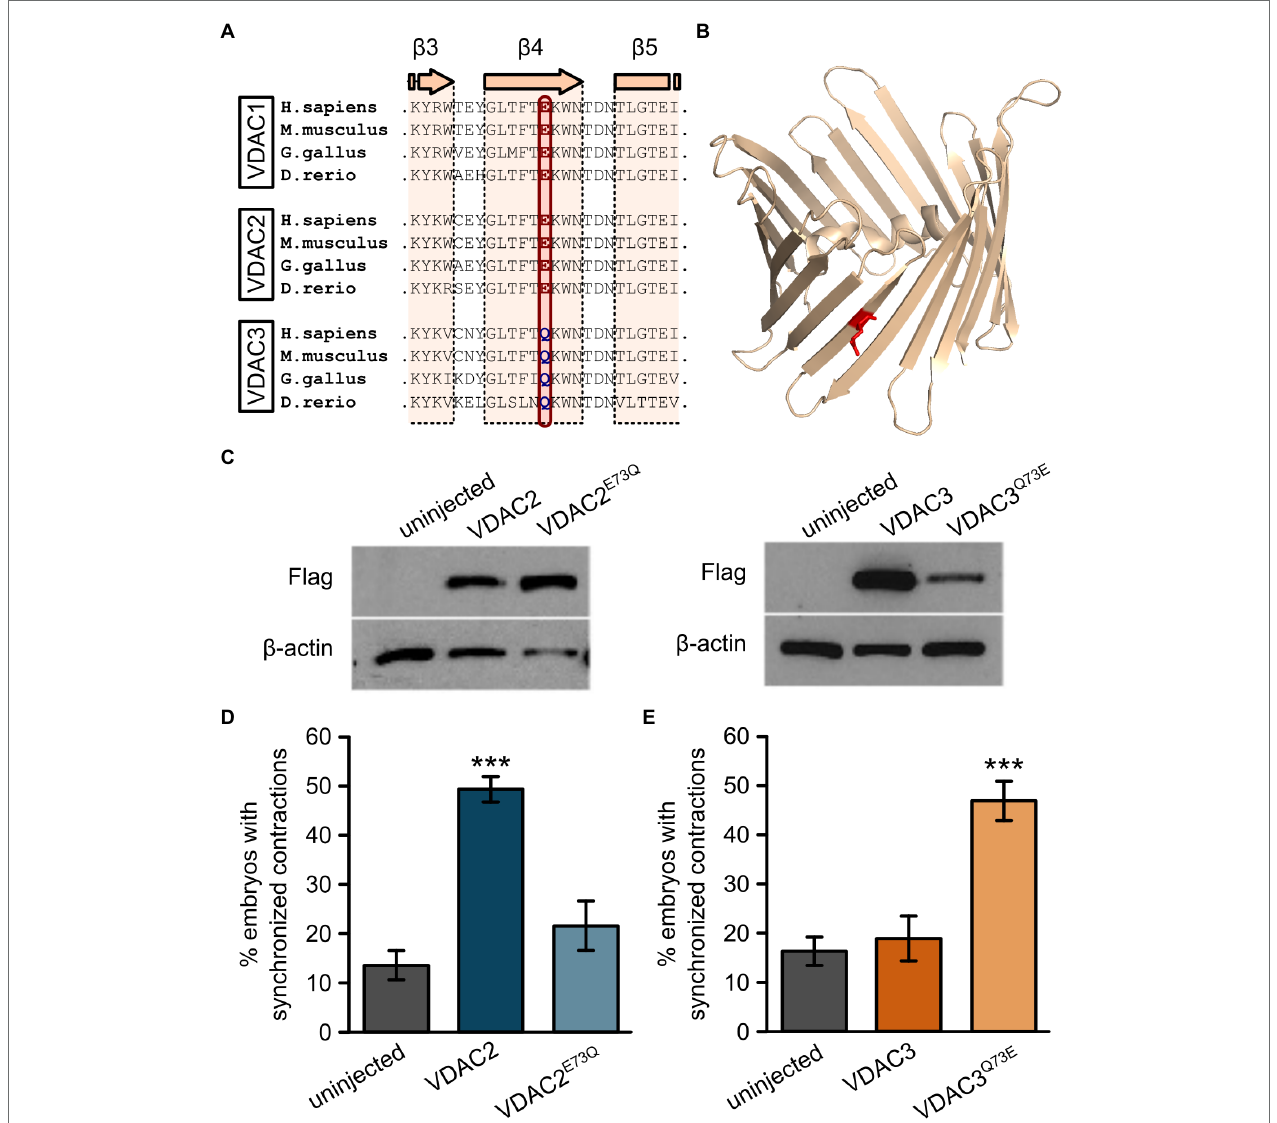
FIGURE 6 | E73 is the critical amino acid residue that determines the ability of VDAC2 to suppress cardiac fibrillation in the tremblor/ncx1h mutant. (A) Alignment of protein sequences of VDAC1, 2, and 3 from different species. In all the species examined the position corresponding to zebrafish residue 73 is consistently occupied by a glutamate (E) in VDAC1 and VDAC2, whereas this position is occupied by glutamine (Q) in VDAC3. (B) Three-dimensional model of the VDAC2 protein (pdb: 4bum) showing the location of amino acid 73 in β -sheet 4 in red. (C) Western blot analysis of lysates from 30 hpf uninjected embryos or embryos injected with 25 pg. FLAG-tagged wild type and point mutant VDAC mRNA. β -actin was used as a loading control. (D) Mutation of E73 to Q in VDAC2 abrogates its ability to suppress cardiac fibrillation in tremblor/ncx1h mutants (49.7 ± 2.8%, N = 3, n = 144 with VDAC2 in contrast to 21.7 ± 5.1%, N = 3, n = 155 with VDAC2 E73Q ). (E) Vice-versa, by mutating Q73 to E, VDAC3 gained the ability to restore rhythmic cardiac contraction in tre mutants (19.0 ± 4.4%, N = 3, n = 182 with VDAC3 in contrast to 47.2 ± 4.3%, N = 3, n = 145 with VDAC3 Q73E ). Overall rescue percentages represent the mean rescue percentage ± s.e.m. from N independent experiments, using a total of n